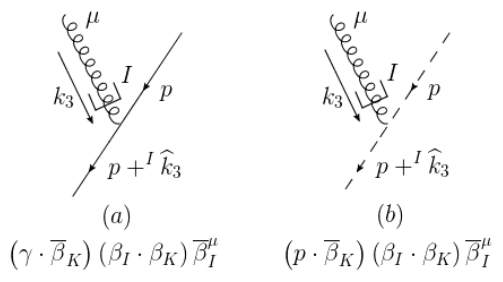
Figure 30. Vertices of t (cid:27) A where the propagators with momentum p (cid:22) are ( a ) fermions or ( b ) scalars, depicted at pinch surface (cid:26) f (cid:27) g (= (cid:26) f (cid:27)(cid:28) g ). At the bottom of each (cid:12)gure we show the leading contribution of this vertex in the neighborhood. To obtain such values, note that k (cid:22) in the expressions because it is parallel to (cid:12) hc I only its (cid:12) I -component, which is O ( (cid:21) ), enters the vertex. Based on the expressions under both (cid:12)gures, it is clear that the contribution from v (cid:22) to the leading term is in fact